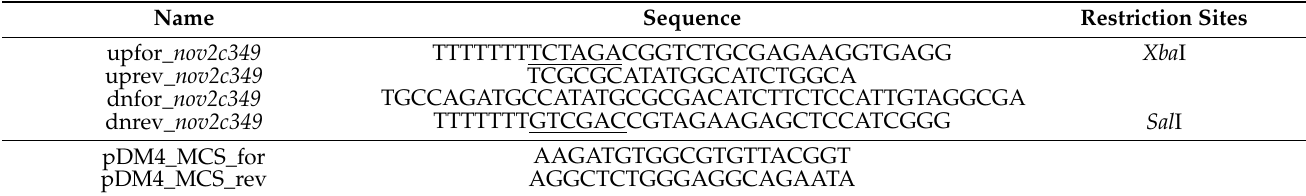
Table 1. Primers used for cloning and construction of unmarked gene deletions. Underlined: restriction sites.